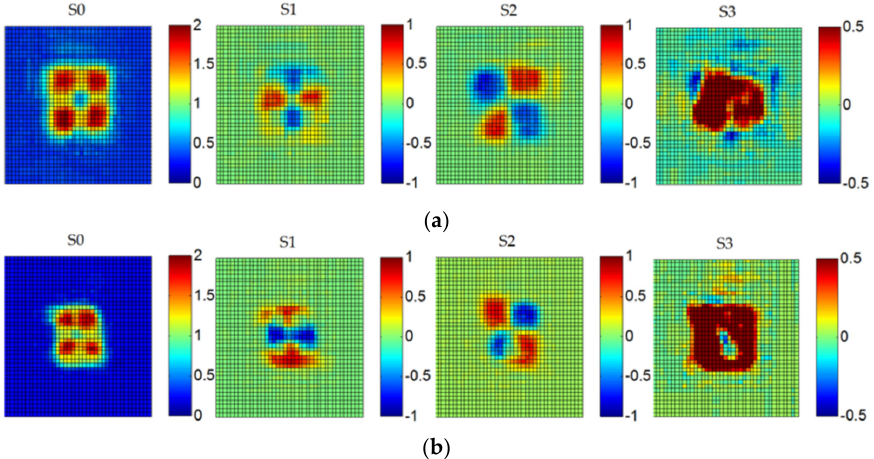
Figure 4. Spatial distributions of Stokes vectors of S 0 , S 1 , S 2 , and S 3 : ( a ) radially polarized light and ( b ) azimuthally polarized light.